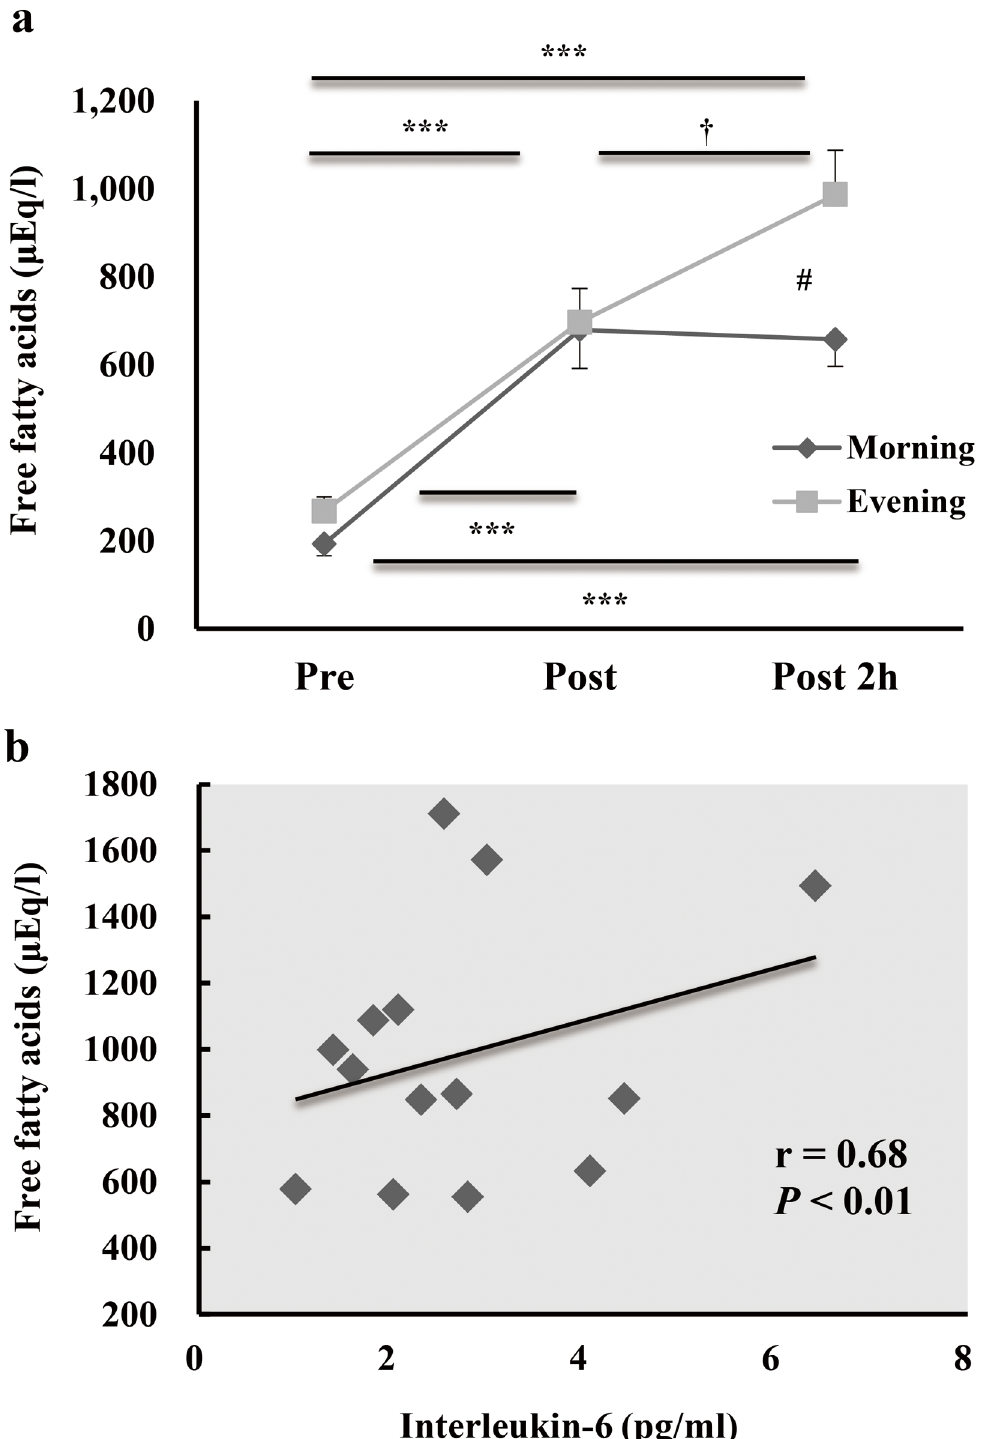
Fig 2. The relationship between the free fatty acids and IL-6 during morning and evening of acute endurance exercise. Serum concentrations of free fatty acids (a) before (Pre), immediately after (Post), and 2 h after (Post 2 h) exercise. Data represent the mean ± standard error. *** P < 0.001, compared with values at pre-exercise. † P < 0.05, compared with values immediately after exercise. # P < 0.05, significant difference between the morning and evening values. The relationship between levels of interleukin-6 immediately post exercise and free fatty acids 2 h post exercise in the evening (r = 0.68, P < 0.01) (b).